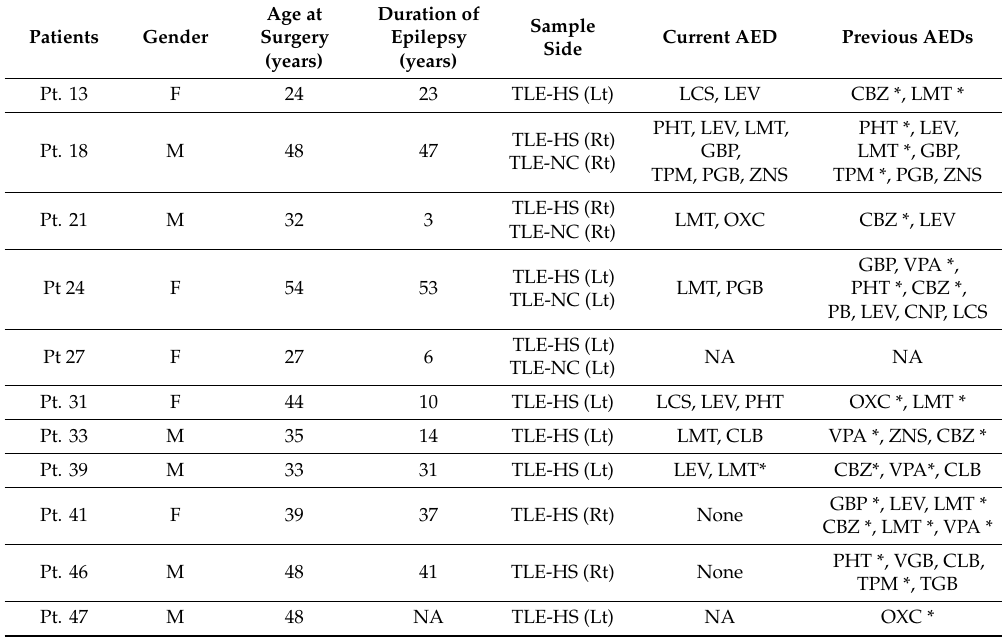
Table 1. Clinical data of patient